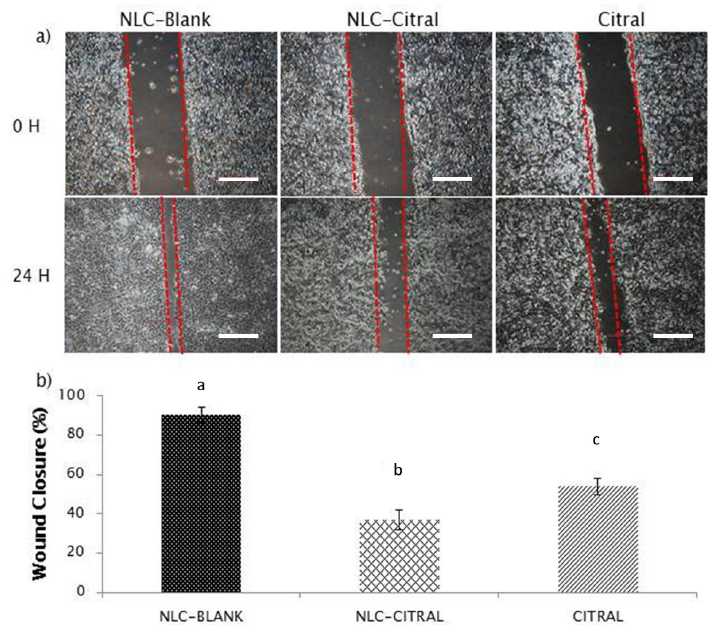
Figure 2. The representative images and bar chart analysis of wound healing treated with 26 µg/mL (IC40) of NLC-Citral, citral, and NLC-Blank for 24 h. The wound closure was measured in between the wound scratched. Each value in the bar chart is represented as mean ± SD and the experiment was performed in triplicate. Significance indicated by different alphabet was set at p < 0.05, comparing between groups. The scale bars show 500 px (13.2 cm).